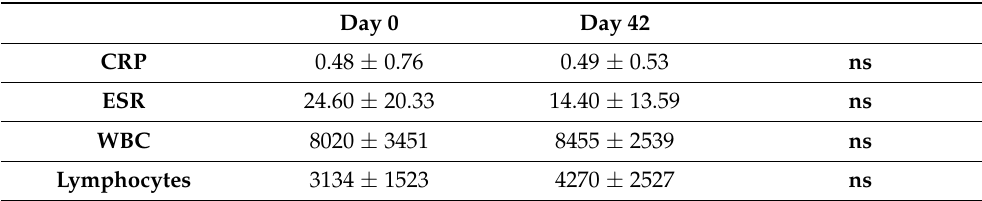
Table 5. Changes in immunology and inflammation parameters across time points. Data are shown as mean ± standard